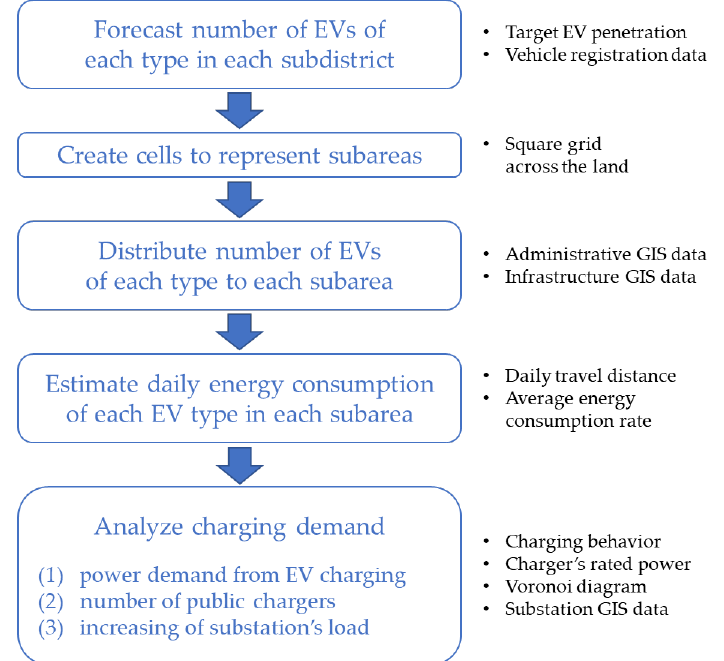
Figure 1. Overview of proposed methodology.